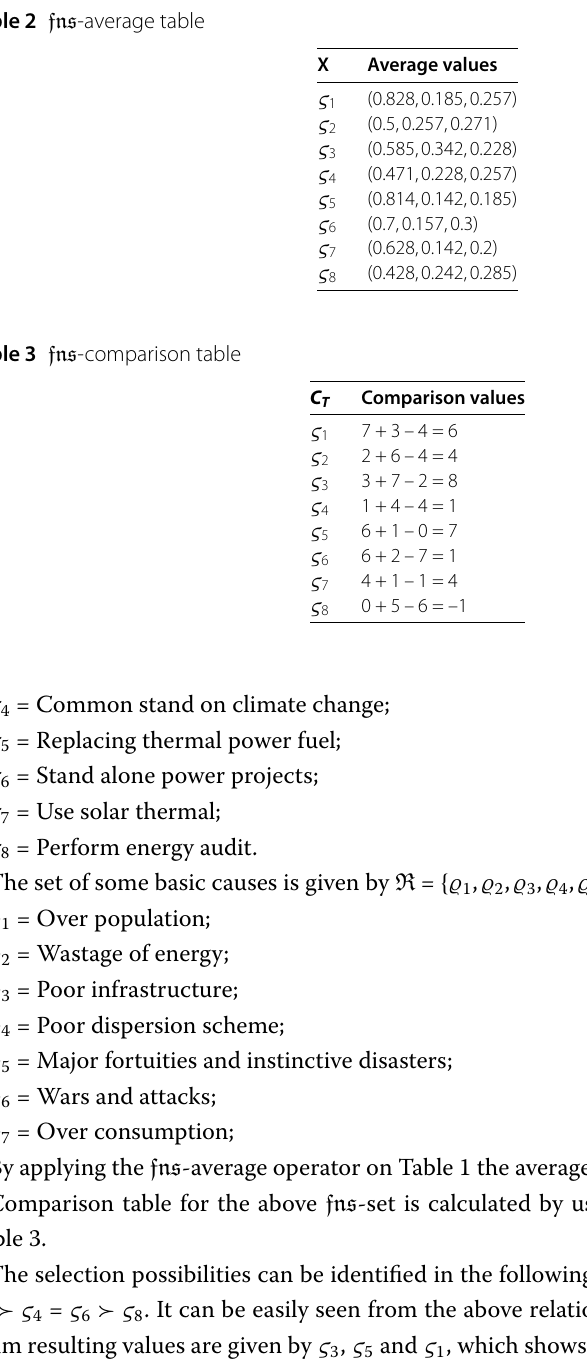
Table 2 fns -average table